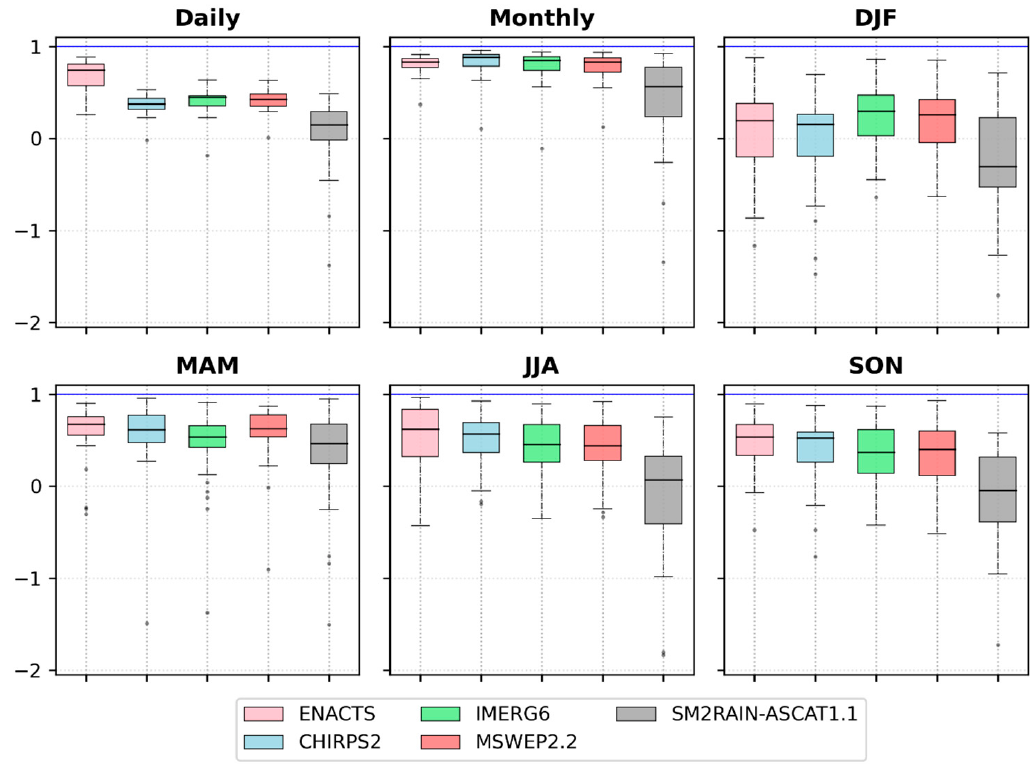
Figure 8. Modified Kling-Gupta efficiency (KGE’) between different precipitation datasets and gauge observations at different temporal scales. The horizontal blue line indicates the optimum value for KGE’.